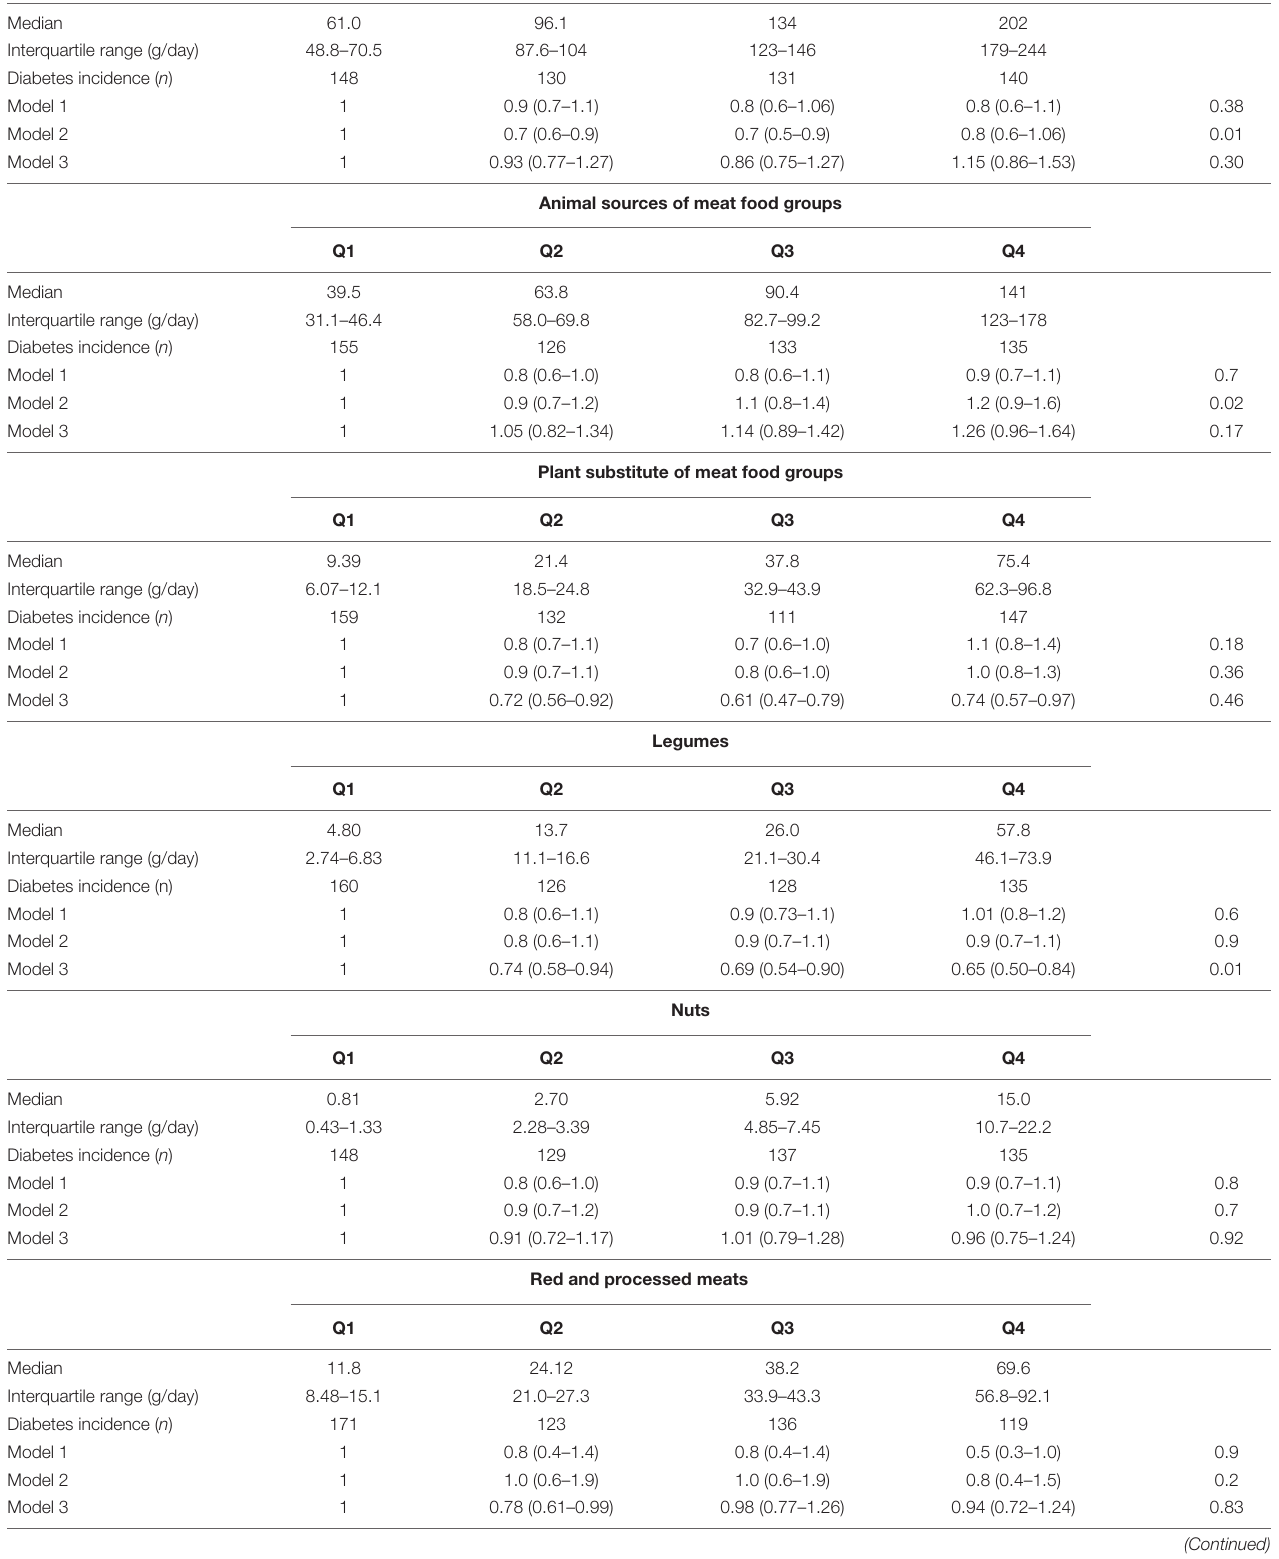
Total animal and plant substitutes of meat food groups